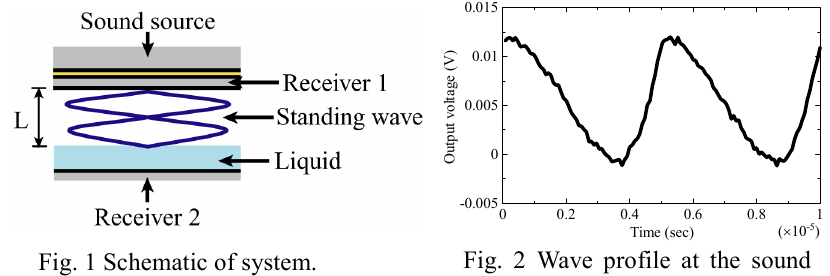
Fig. 1 Schematic of system. Fig. 2 Wave profile at the sound resonance (solid wall, 101